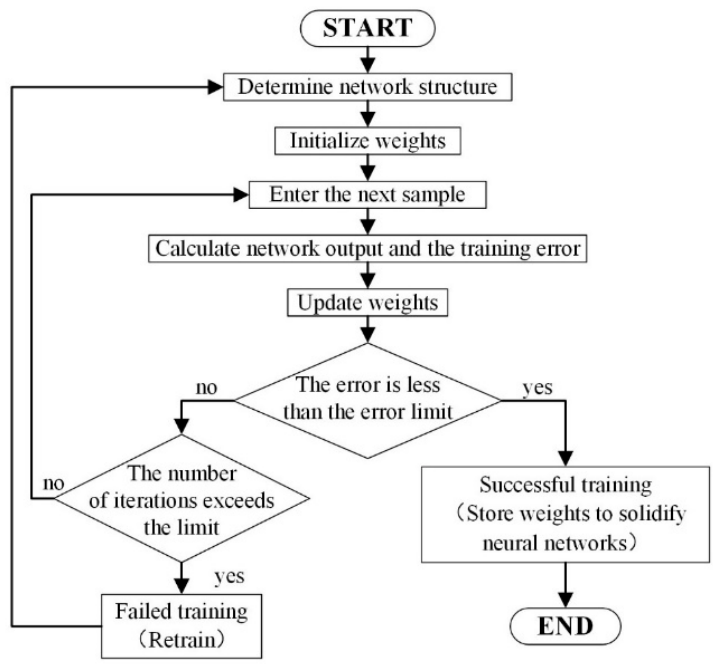
Figure 10. ANN2 training flowchart.